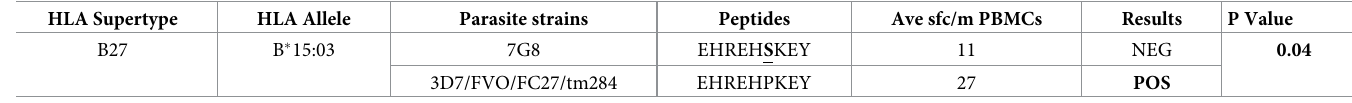
Table 4. Outcome of subject v04 PBMC stimulation with allelic peptide